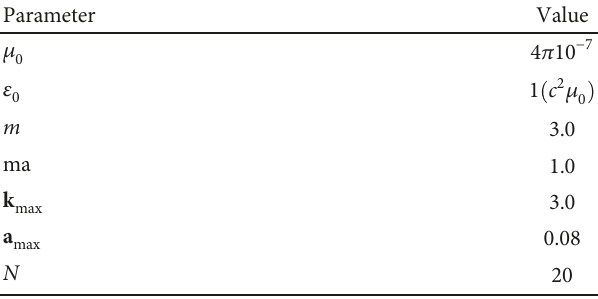
Table 1: Parameter values of the implemented CPML ABC. Parameter